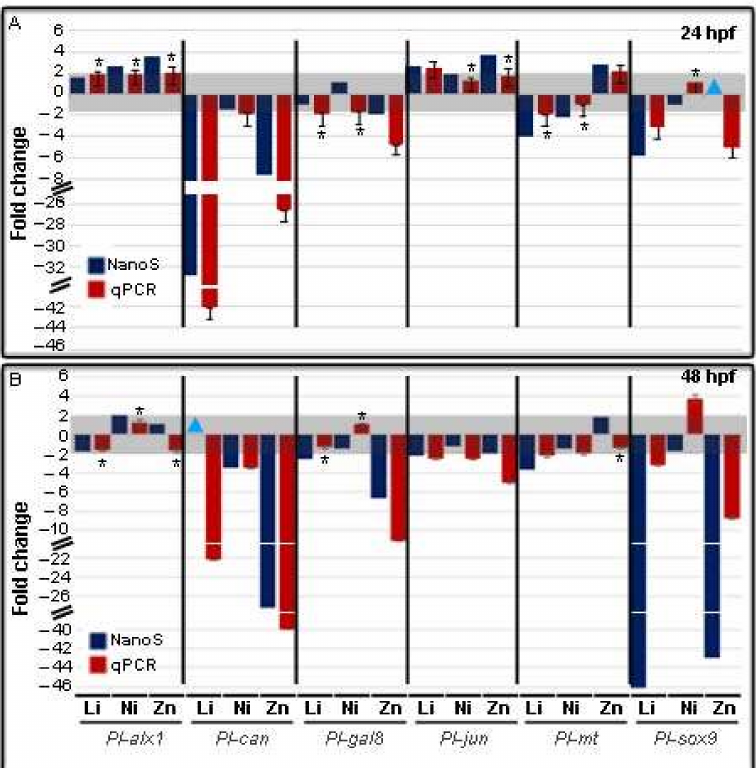
Figure 7. Comparison of qPCR data of gene transcription levels in Li-, Ni-, and Zn-embryos with NanoString data. Pl-alx1, Pl-can, Pl-gal8, Pl-jun, Pl-mt, and Pl-sox9 mRNA levels were analyzed compared to control embryos using the endogenous gene Pl-Z12-1 for normalization. The gray boxes indicate the threshold for insignificant changes following Li, Ni, and Zn treatments, i.e., fold values between − 2 and + 2, at 24 ( A ) and 48 ( B ) hours post-fertilization (hpf). Symbols: NanoS, NanoString data, blue bars; qPCR data, red bars; Li, Li-embryos; Ni, Ni-embryos, Zn, Zn-embryos. The light blue triangles indicate not quantifiable values. Each bar of qPCR data represents the mean of three independent experiments of qPCR ± SD. QPCR mean values were significantly different according to the one-way ANOVA ( p < 0.05), followed by the Tukey’s test. The asterisks (*) indicate statistically not significant variations to the relative